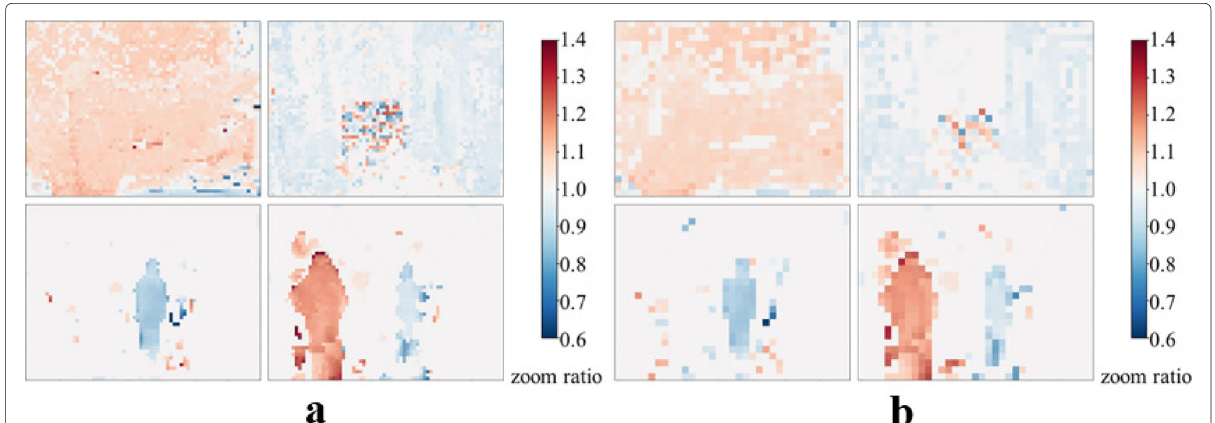
Fig. 15 Zoom ratios for simulation depth videos. a 8 × 8 block size and b 16 × 16 block size